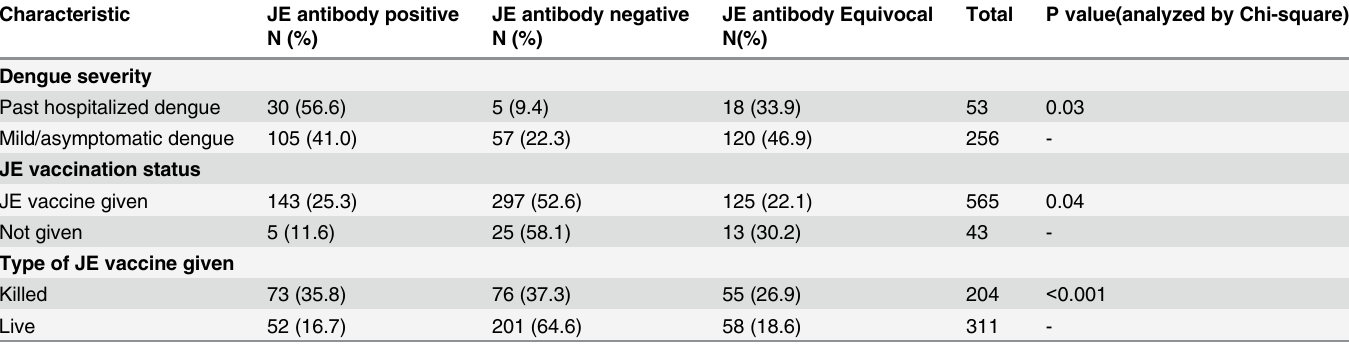
Table 2. Association of JE antibody positivity with past hospitalization due to dengue, JE vaccination status and the type of JE vaccine given in children. Characteristic